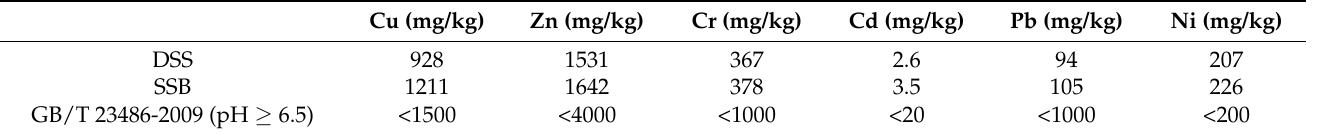
Table 6. Heavy metal contents of SSB and DSS and the standard limits of GB/T 23486-2009 “Disposal of sludge from municipal wastewater treatment plant-Quality of sludge used in gardens or parks (in